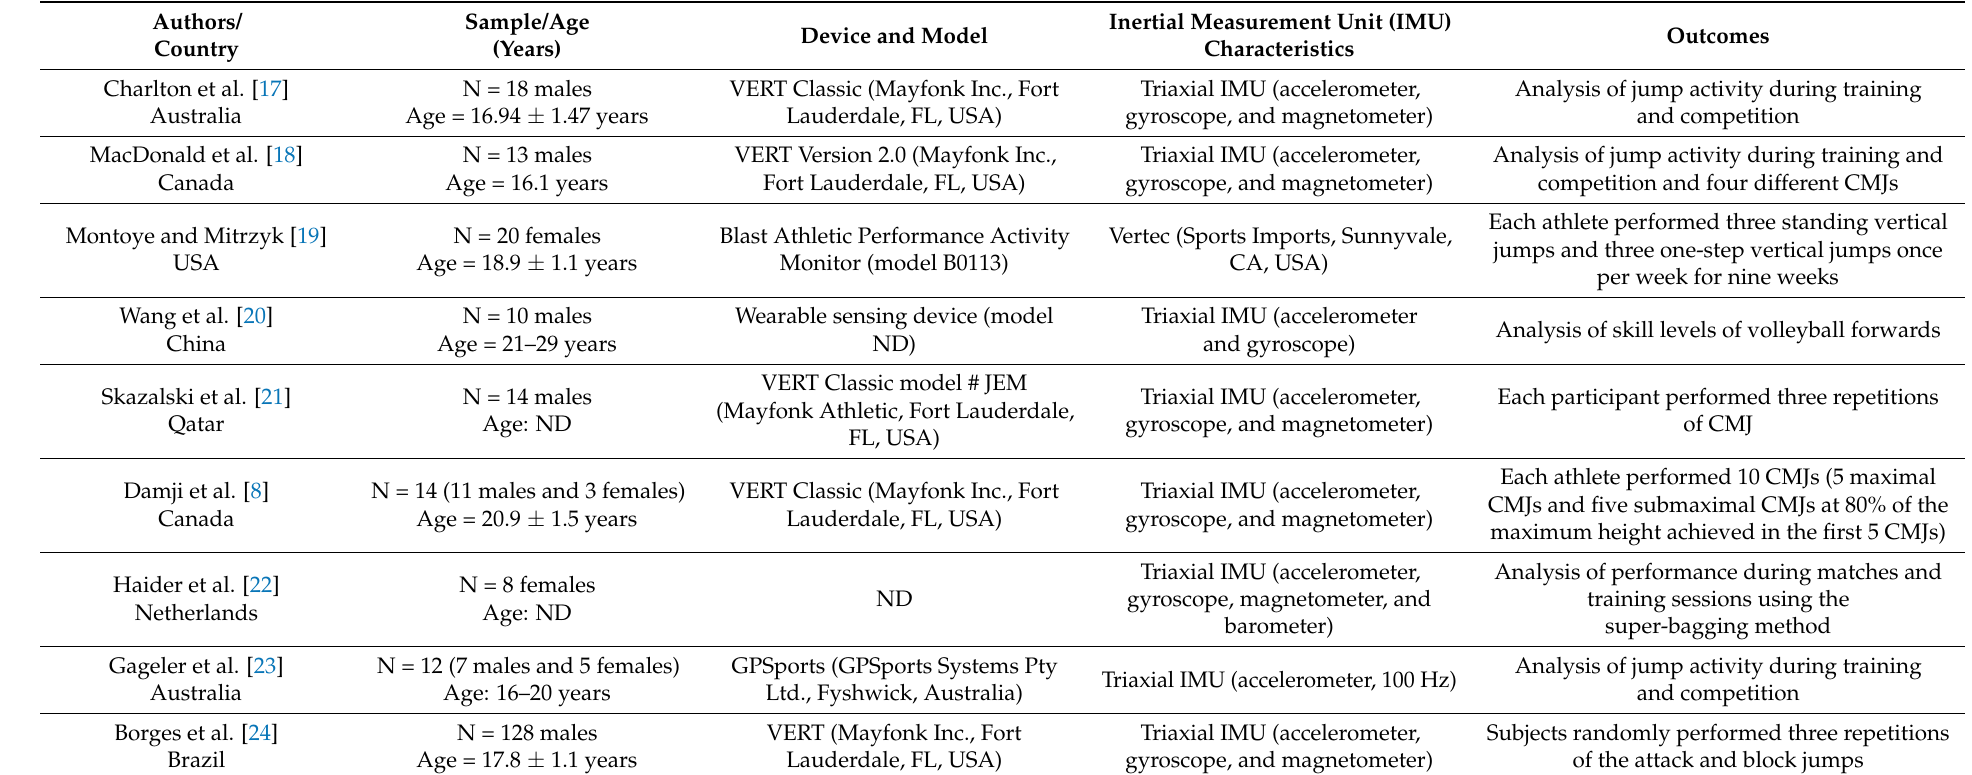
Table 2. Characteristics of the studies included in the